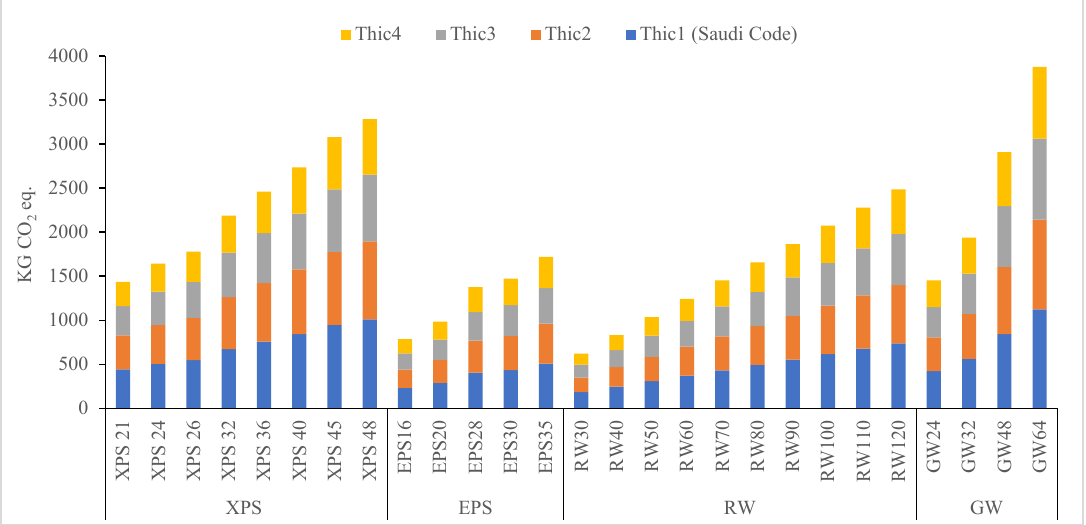
Figure 13. Comparison of total carbon dioxide KG CO 2 eq values.